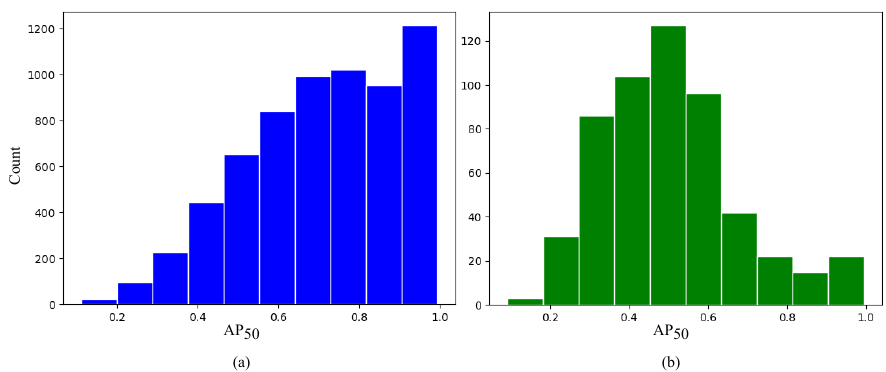
Figure 7. The histograms of AP 50 of images in the training set ( a ) and validation set ( b